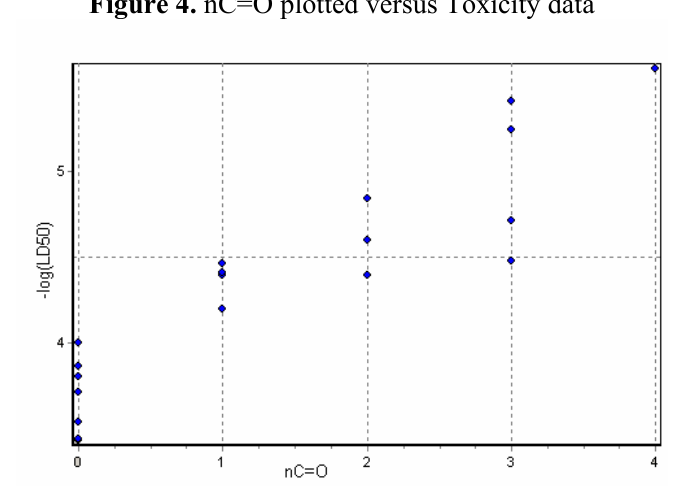
Figure 4. nC=O plotted versus Toxicity